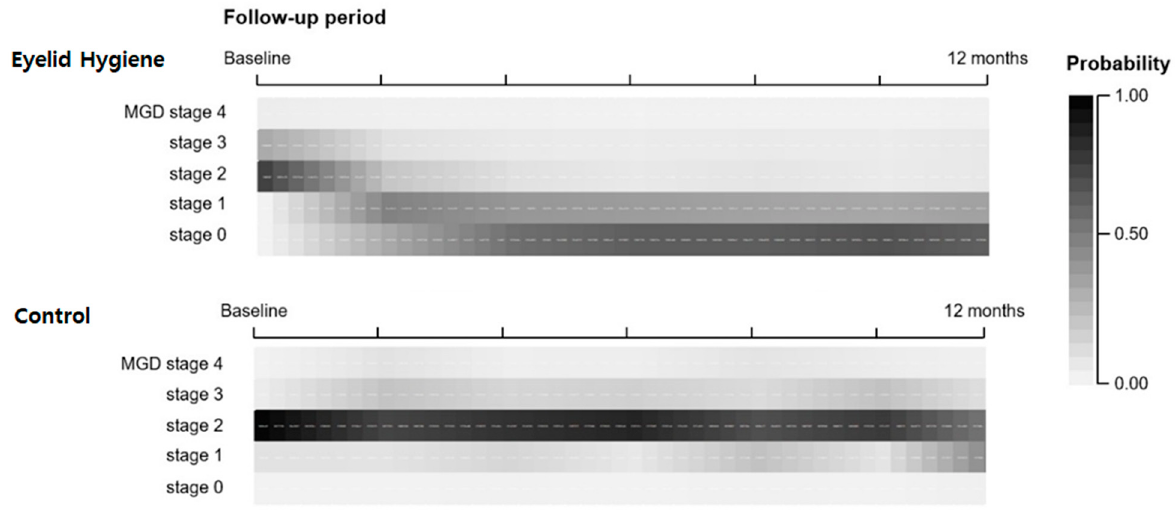
Figure 1. Heatmap charts showing the estimated probabilities of MGD stages in the treatment groups for 12 months. Table 3. Impact of eyelid hygiene on meibomian gland dysfunction treatment duration. Treatment Duration